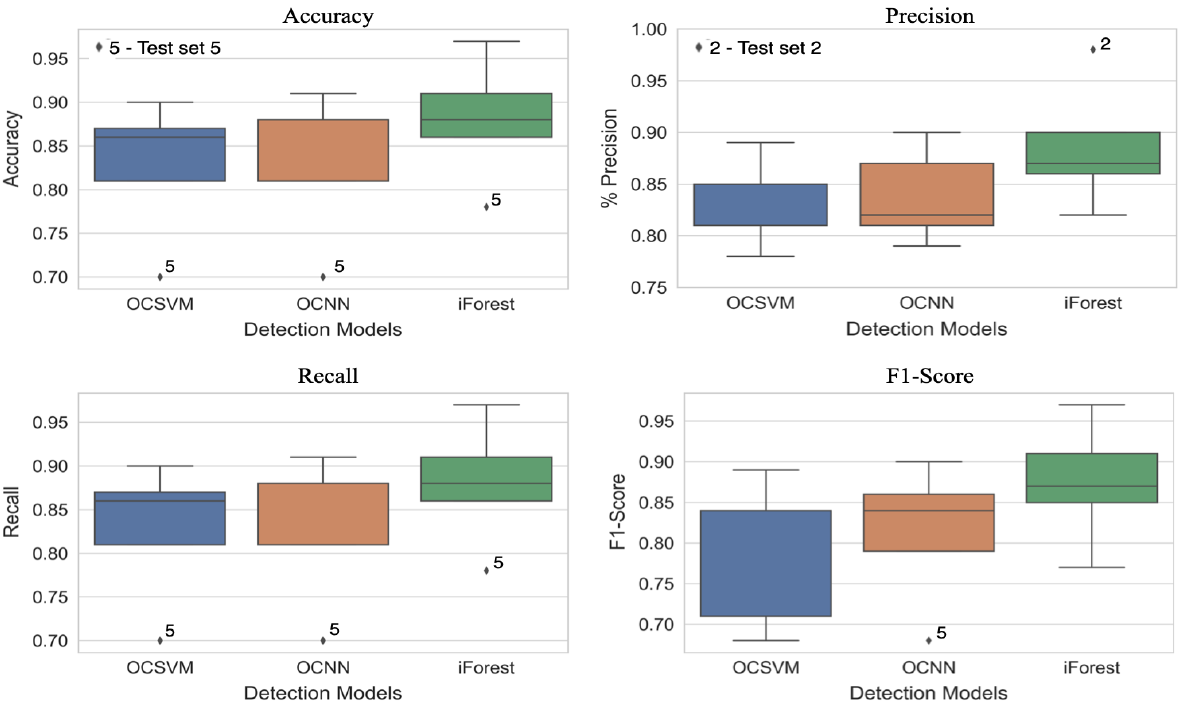
Figure 9. Box plot of OCSVM, OCNN, and IF performance